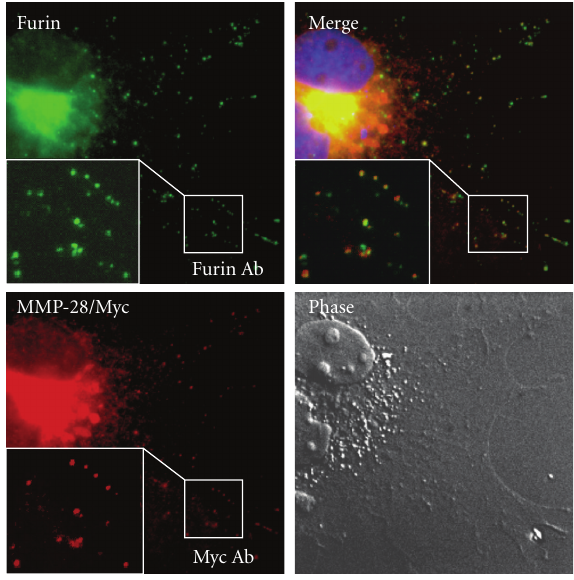
Figure 4: Complex formation between MMP-28 and furin as examined by coimmunoprecipitation and